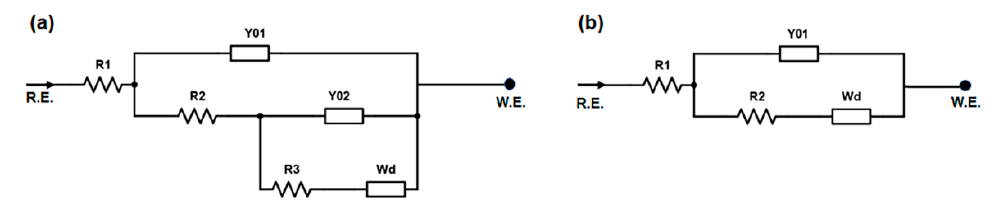
Figure 11. Equivalent circuit models used for fitting the electrical impedance data of hydrogel samples hydrated in ( a ) water and ( b ) PBS solution.